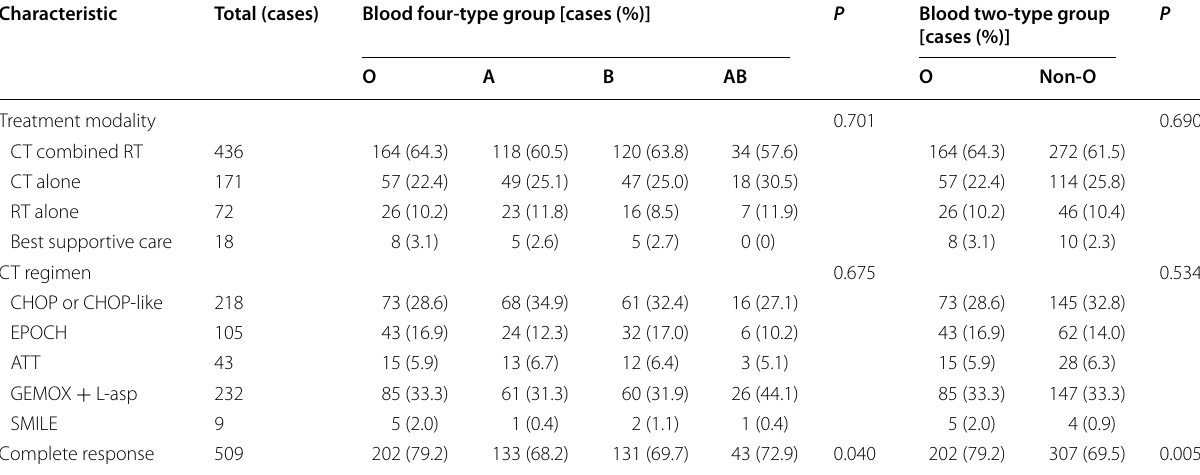
CT chemotherapy, RT radiotherapy, CHOP cyclophosphamide doxorubicin + etoposide doxorubicin vincristine cyclophosphamide prednisone, ATT alternating triple therapy ( CHOP-B , + + + + cyclophosphamide doxorubicin vincristine bleomycin prednisone, IMVP-16 ifosfamide + + + + DHAP , dexamethasone cisplatin cytarabine), GEMOX L-asp gemcitabine + + + dexamethasone methotrexate ifosfamide -asparaginase + + + l +